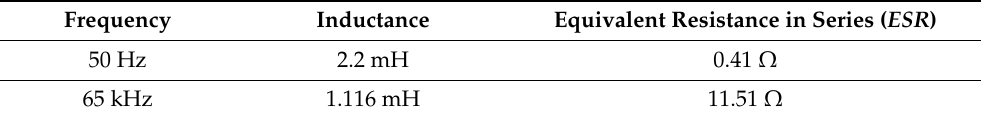
Figure 7. Inductor built by student. Table 3. Characterization of the prototype inductance.